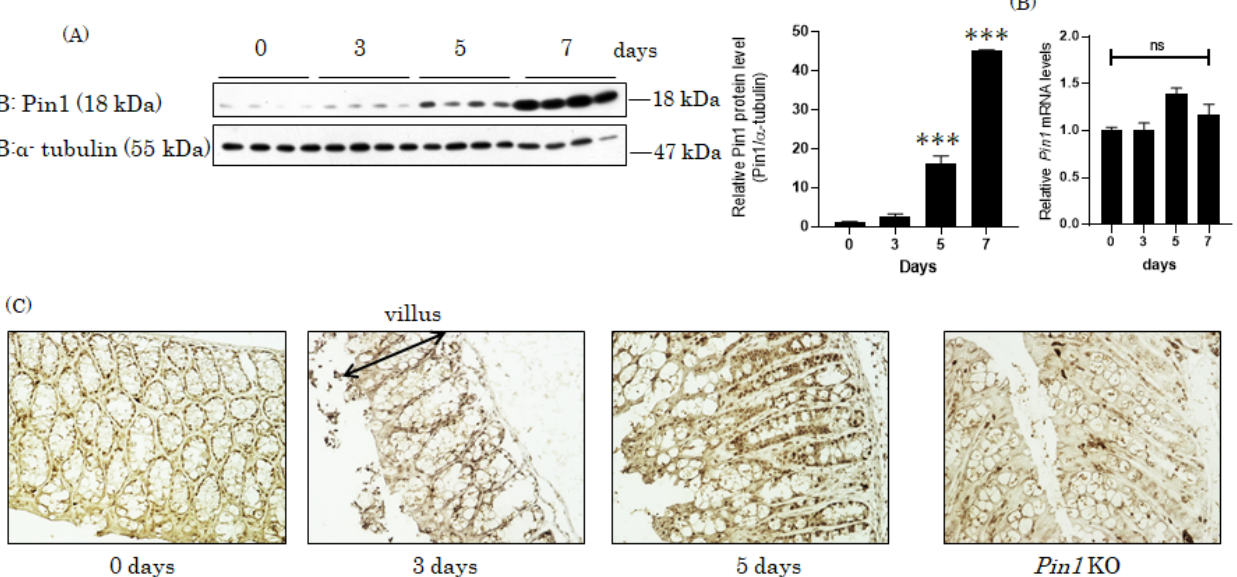
Figure 1. Pin1 expression was markedly increased in mice with DSS-induced colitis. ( A , B ) The colons were isolated from WT mice treated with drinking water containing DSS for 3, 5 and 7 days (n = 5–6), and Pin1 protein (a) and mRNA (b) levels were determined by immunoblotting and real time -PCR (RT-PCR), respectively. The ratio of Pin1 protein/ tubulin is presented as a bar graph (right panel of a). The Y axis of (b) represents ΔΔ CT. Significant differences were identified by applying a one-way ANOVA followed by Tukey’s multiple comparisons test. ns, not significant, *** p < 0.001 Values are means + SEM. ( C ) Colonic samples isolated from WT mice treated with drinking water containing DSS for 0, 3 and 5 days and global Pin1 KO mice without treatment were stained immunohistochemically. 3.2. Global Pin1 KO Mice Were Resistant to DSS-Induced Colitis Development Since Pin1 protein was markedly increased in the colonic tissues of DSS-treated mice, we speculated that Pin1 is involved in the development of colitis. To address this possi- bility, first, global Pin1 KO mice, generated by crossing Pin1 flox and CAG-Cre mice, were subjected to experiments resulting in the development of DSS-induced colitis. As ex- pected, Pin1 expressions were fully deleted in the colons of KO mice (Supplementary Fig- ure S1A). After 7 days of DSS treatment, the animals were weighed, colon length was measured and microscopic observations were performed. While marked body weight loss occurred in the normal mice treated with DSS for 7 days, Pin1 KO mice showed only slight weight loss (Figure 2A). The colon length reduction was also milder in the Pin1 KO than in the control mice (Figure 2B). The microscopic observations of colonic tissues also showed severe tissue destruction in response to DSS treatment in normal mice, while the severity of these changes was significantly attenuated in Pin1 KO mice (Figure 2C). In the colons of DSS-treated mice, the expressions of inflammatory cytokines such as Tnf α , Il6 and Il1b and the chemokine Mcp1 were markedly elevated, and also showed sig- nificant normalization in the Pin1 KO mice (Figure 2D). In addition, active caspase 3, showing the presence of apoptotic cells in the epithelial layer, was markedly increased in the colonic tissues of DSS-treated normal mice, an increase which was also attenuated in the Pin1 KO mice (Figure 2E). These datasets indicated that deletion of the pin1 gene ame- liorates DSS-induced colitis development. In other words, Pin1 plays an essential role in colitis development.